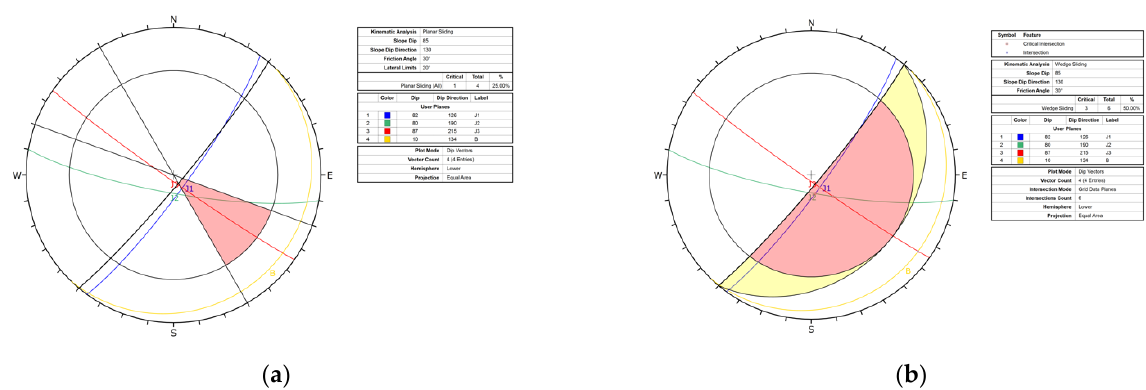
Figure 11. Kinematic analysis for: ( a ) planar sliding and ( b ) wedge sliding failure in sub-region U2.